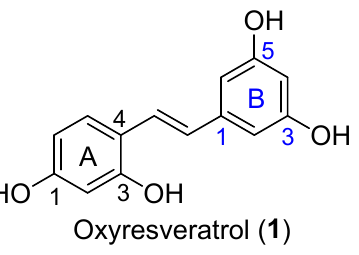
Figure 1. Chemical structure of oxyresveratrol ( trans -2,3 ′ ,4,5 ′ -tetrahydroxystilbene). Despite the biological activity of COX inhibitors reported in the literature [37], insuffi- cient metabolic stability and a high degree of non-specific binding have been the issues for consideration in lead optimization. Incorporation of fluorine into stilbene-like compounds is one effective way to increase their lipophilicity, resulting in an increase in metabolic stability and membrane permeation. Electron withdrawal by fluorine introduces a strong polarization of the C-F bond, which pronounces the electronic effects for drug-target inter- actions as in the case of celecoxib—the fluorine-containing clinical NSAID and a